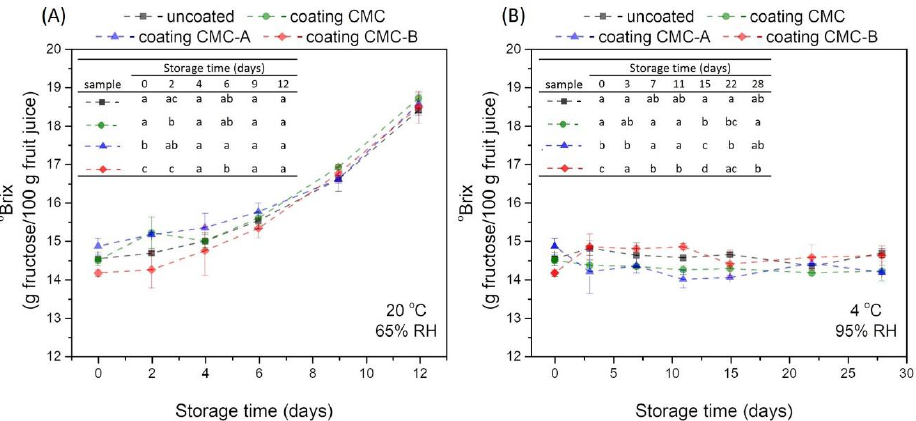
Figure 5. Total soluble solids of uncoated and coated fresh goldenberries as a function of storage time: ( A ) 20 °C and 65% RH and ( B ) 4 °C and 95% RH. Results are expressed as mean ± standard deviation ( n = 6). In the inserted table, different letters on the same analysis day correspond to statistically different values for a 95% confidence level. Usually, total soluble solids rise during fruit ripening due to the gradual degradation of starch and cell wall materials [3], resulting in an increase in the sugar content. On the